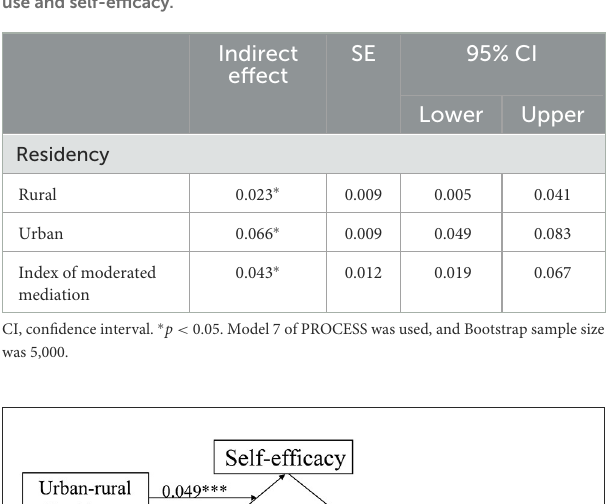
TABLE 7 The moderating effect of urban-rural residency between media use and self-efficacy.